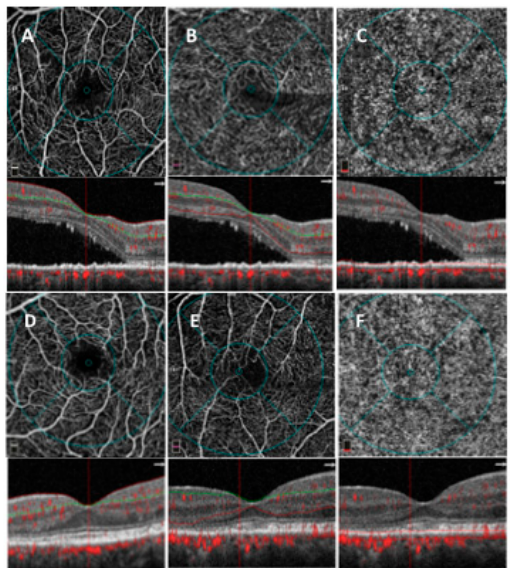
Figure 2. OCT angiography (OCTA) images of patients with CCSC at baseline and at a 4-month follow-up during eplerenone treatment. OCTA images at baseline of superficial ( A ), deep ( B ), and choriocapillaris ( C ) layers (first row). OCTA images after treatment at 4-month follow-up of superficial ( D ), deep ( E ), and choriocapillaris ( F ) layers (second row). Complete fluid resolution rate at 60 and 120 days was, respectively, 72.4% (15 patients) and 100%